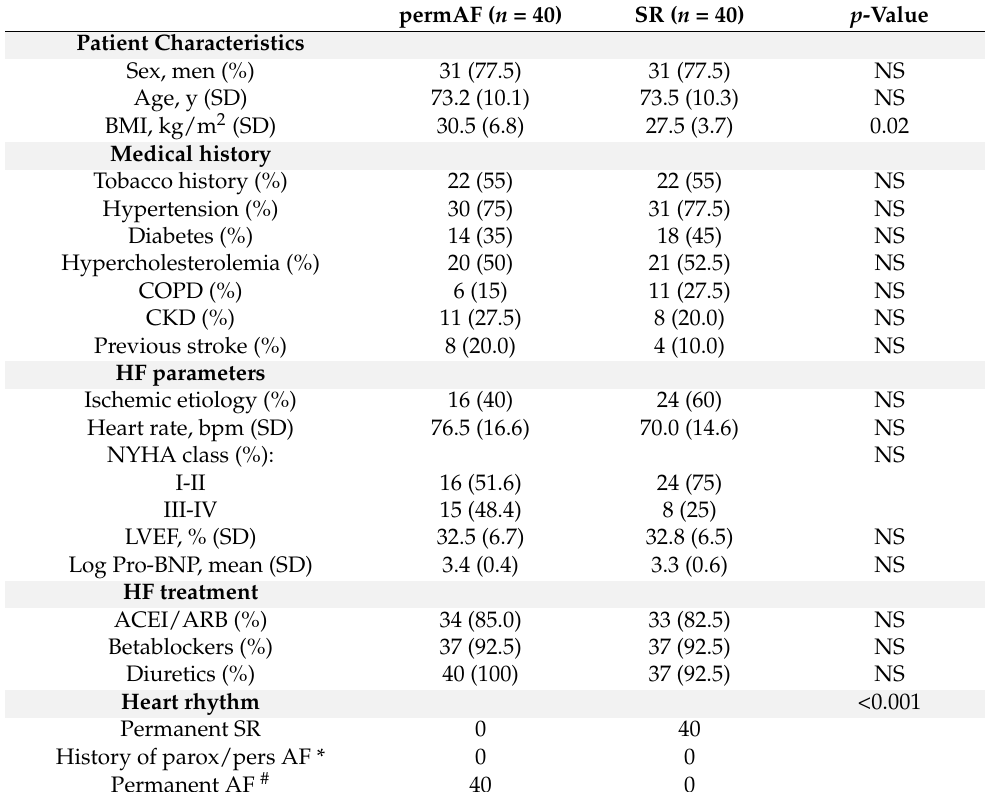
Table 1. Characteristics of the replication